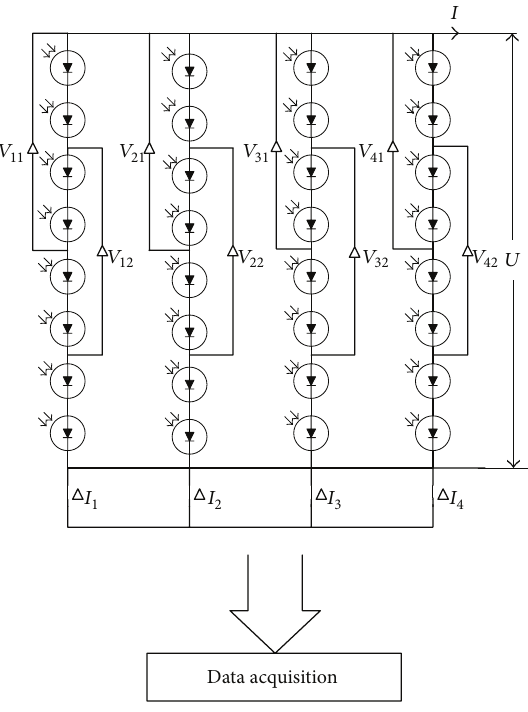
Figure 1: A new fault detection